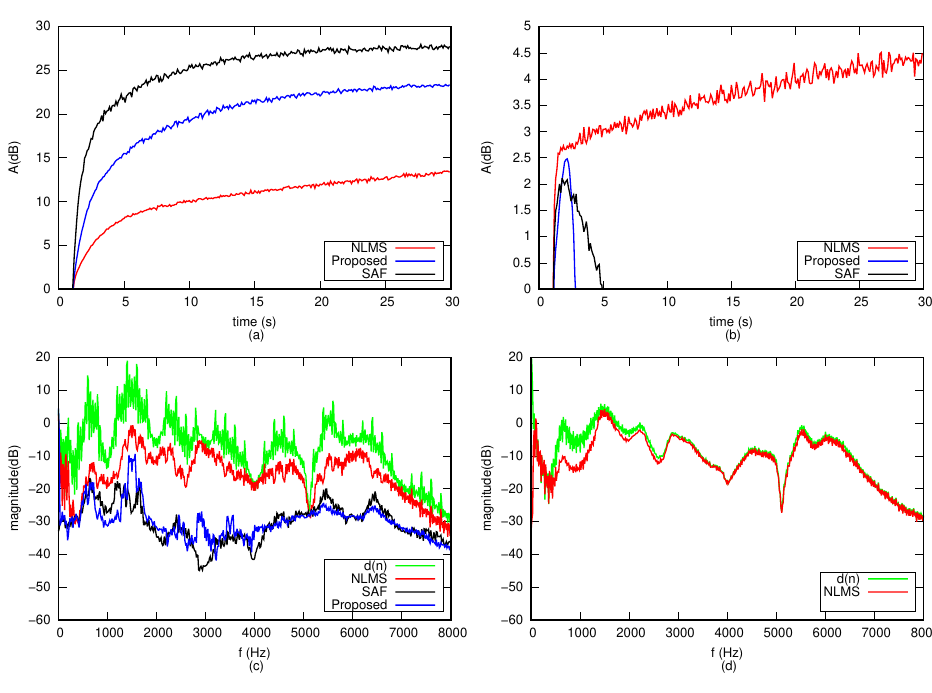
Figure 15. Test case 6: comparison of the noise reduction achieved in an ANC system, where: ( a ) x ( n ) is a 50 Hz impulse train; ( b ) x ( n ) is a 10 Hz impulse train; ( c ) spectrum for noise to reduce d ( n ) and residual signal e ( n ) in case of 50 Hz reference signal; ( d ) spectrum for noise to reduce d ( n ) and residual signal e ( n ) in case of 10 Hz reference signal. The control filter length is L =